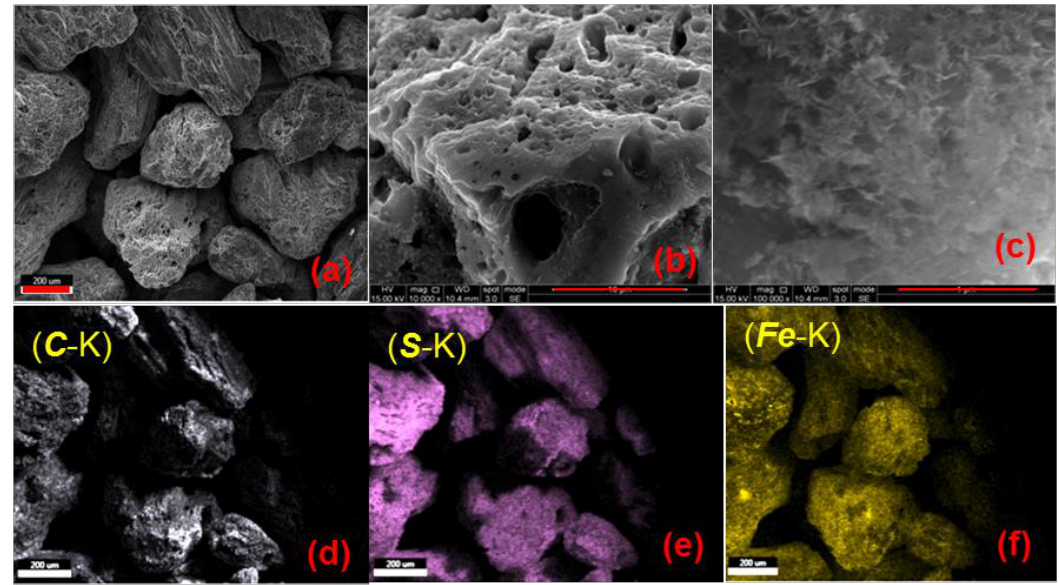
Figure 4. Scanning electron microscopic (SEM) images of MC-Fe-S2 in different magnifications (( a ) – ( c ); ( a ) scale bar: 200 µ m, ( b ) scale bar: 10 µ m, ( c ) scale bar 1 µ m). Energy dispersive X-ray image of MC-Fe-S2 for C-K ( d ), S-K ( e ) and Fe-K ( f ), all scale bars 200 µ m.